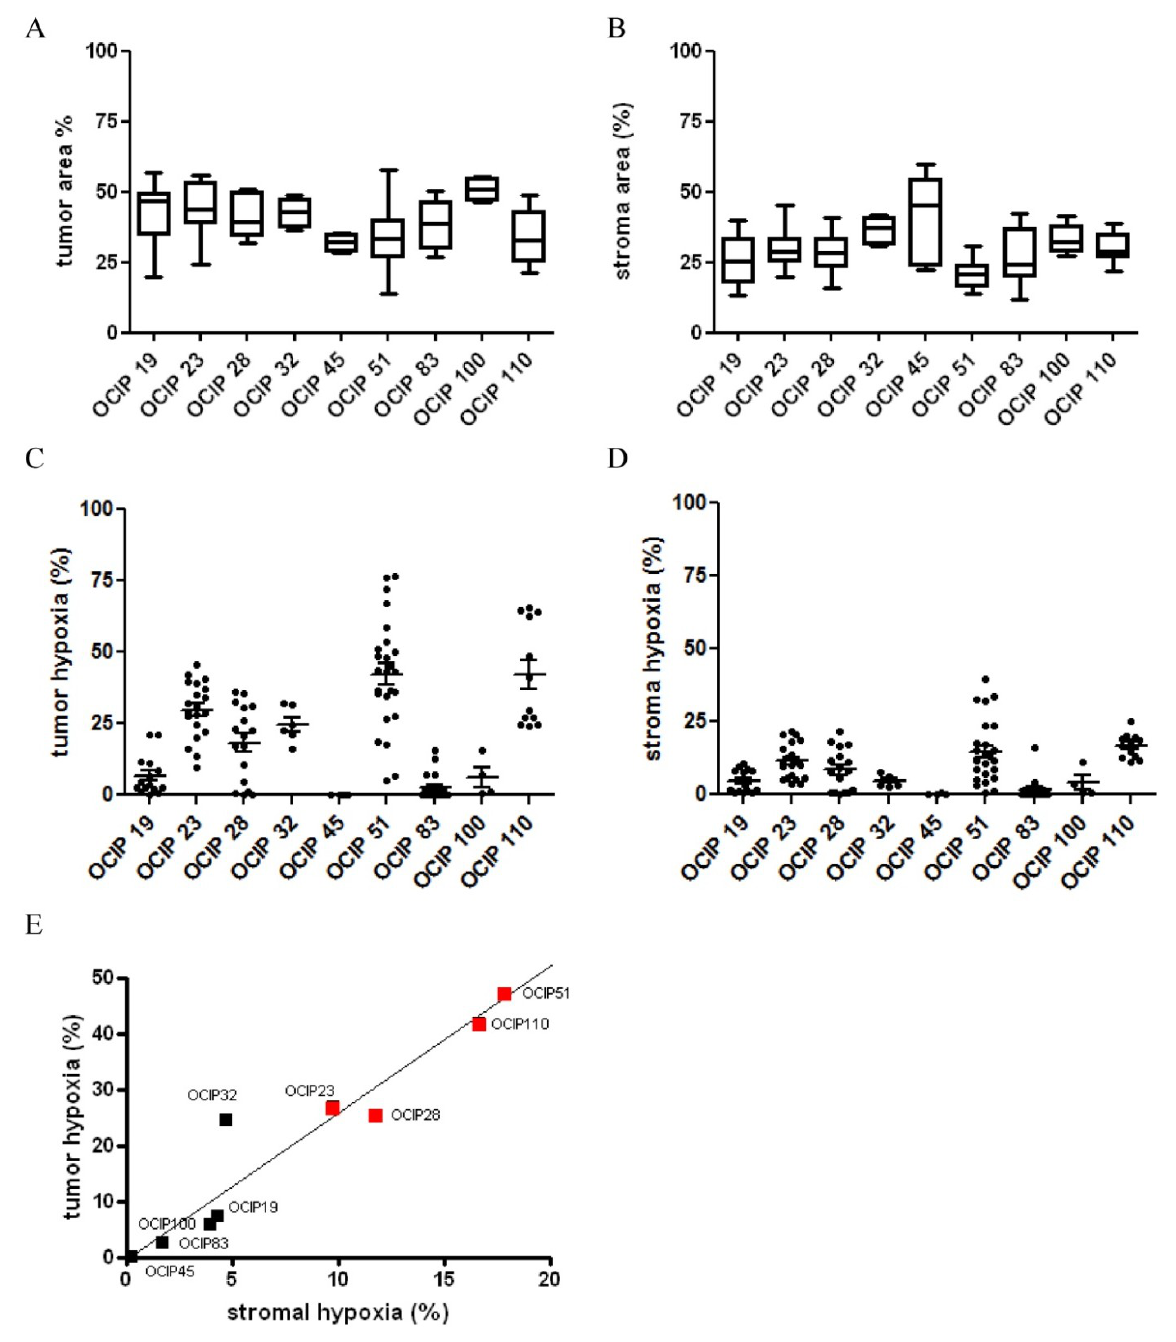
Figure 2. Patient-derived pancreatic xenograft models differ in tumor and stroma content. Classification of EF5 stained sections using the Aperio pattern recognition